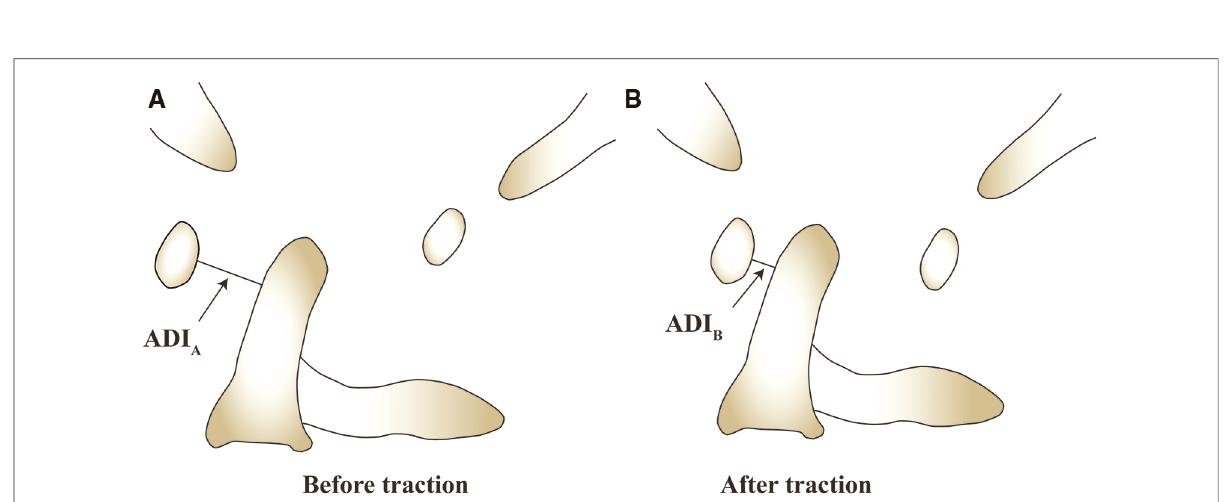
FIGURE 1 ( A ) The measurement of atlas-dens interval, the red section refers to the squeezed spine; ( B ) Angle γ is formed by the tangents lines of the articular surface, the angle θ refers to the coronal atlantoaxial joint inclination angle; ( C ) angle α is similar to angle γ , the angle β refers to the sagittal atlantoaxial joint inclination